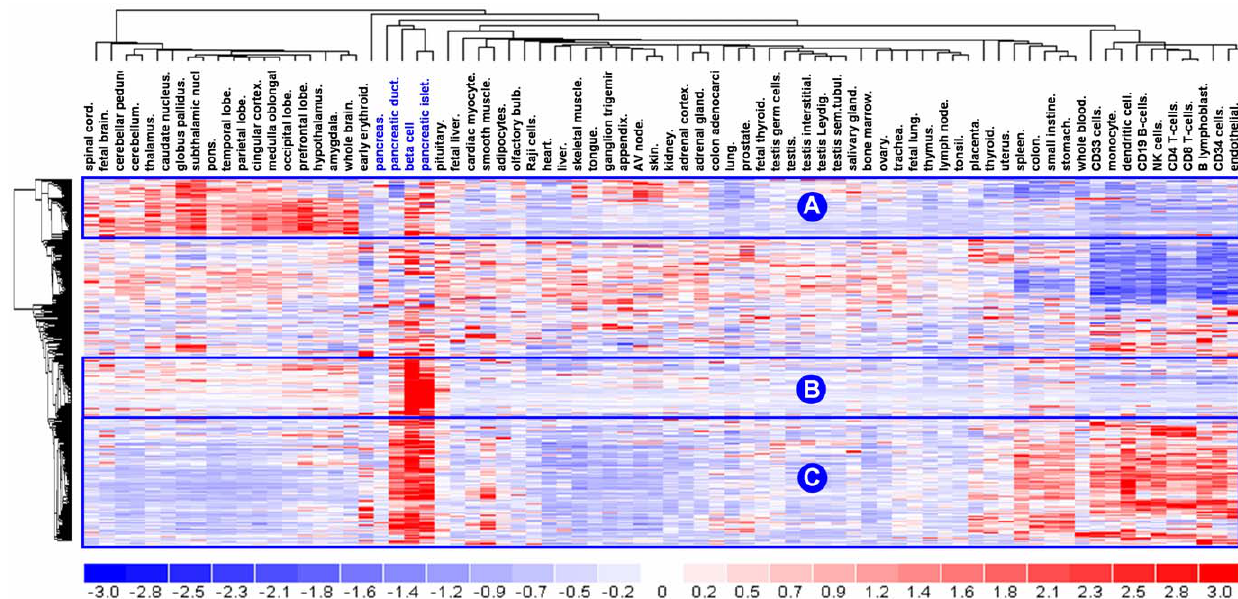
Figure 2. Shared gene clusters between beta cells, neuronal cells and immune cells. The 503 human probe sets corresponding to the 332 conserved beta cell marker genes are visualized by hierarchical clustering in the Human Genome Atlas data set [3]. At least 15% of beta cell marker genes show near absolute beta cell selectivity (beta cell selective cluster B ). Beta cells also share an equally extensive cluster (15%) with various brain regions (neuroendocrine cluster A ), and an even larger cluster (30%) with immune and gut mucosal cells (gut/immunological cluster C ). Statistical enrichment analysis indicates that these clusters accentuate different functions proper to the specialized beta cell phenotype. Blue to red correspond low to high relative expression, as shown in legend (bottom). Relevant genes of clusters A, B and C are shown in Fig. 3.